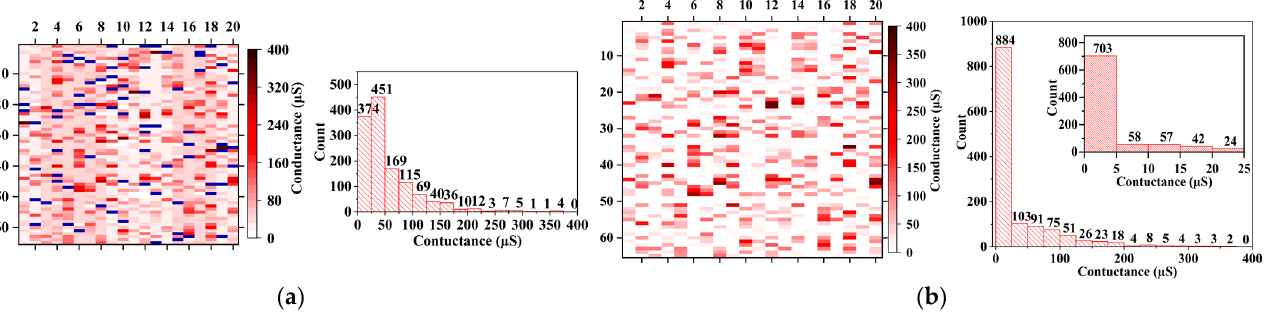
Figure 4. The memristor conductance distribution and the cumulative distribution of the number of devices after 20 trainings, ( a ) before the failed device is replaced, ( b ) after the failed device is replaced. The inset represents an enlarged view of the cumulative number distribution of devices with conductance values ranging from 0 µS to 25 µS.